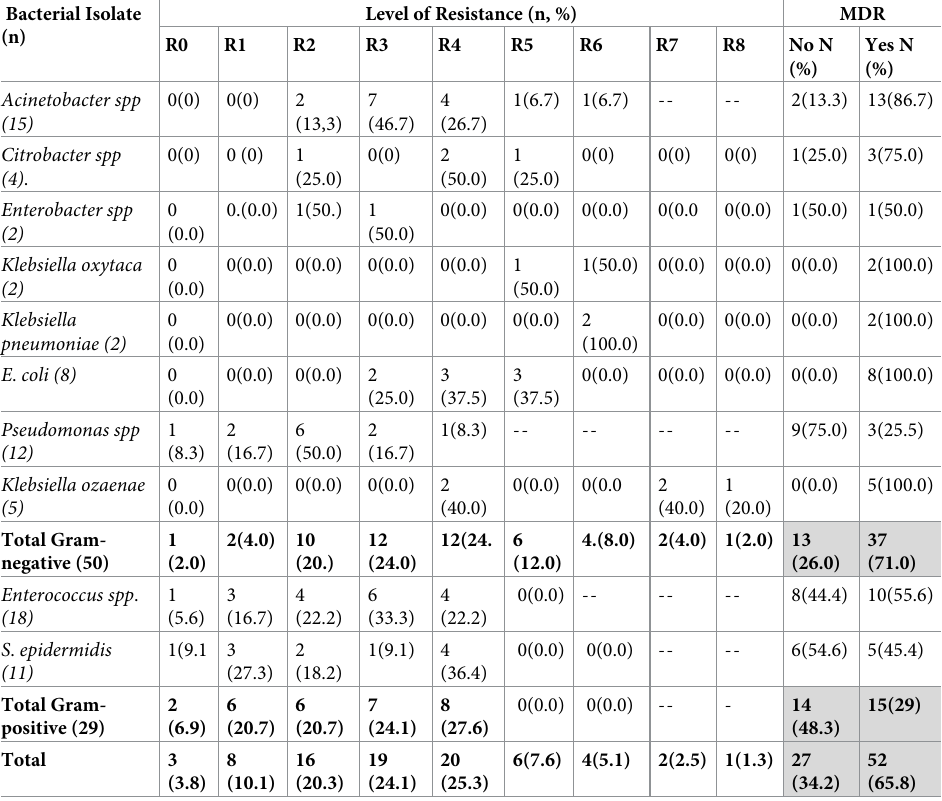
Table 6. Prevalence of multi-antibiotic resistance Gram-positive and Gram-negative bacteria. Bacterial Isolate